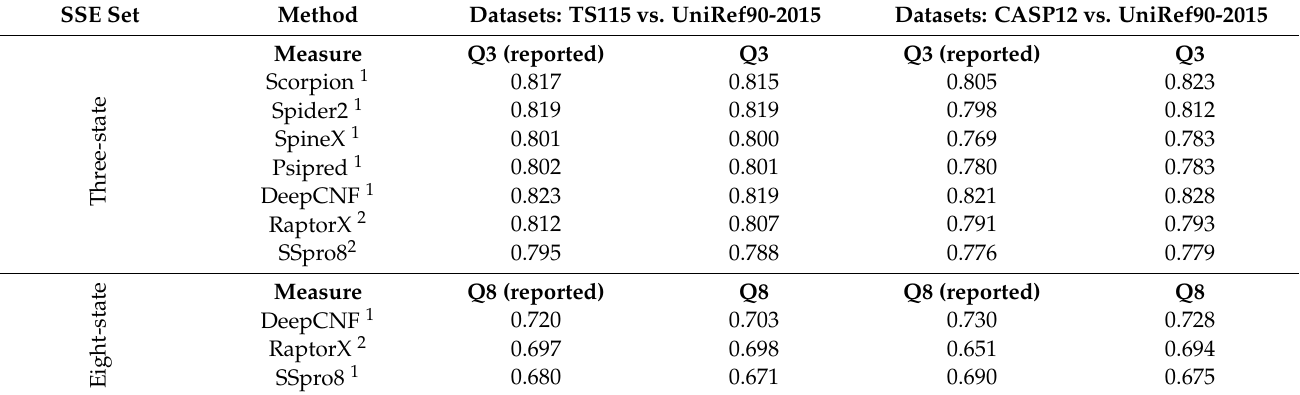
Table 1. Performance pretest results of several state-of-the-art SSP